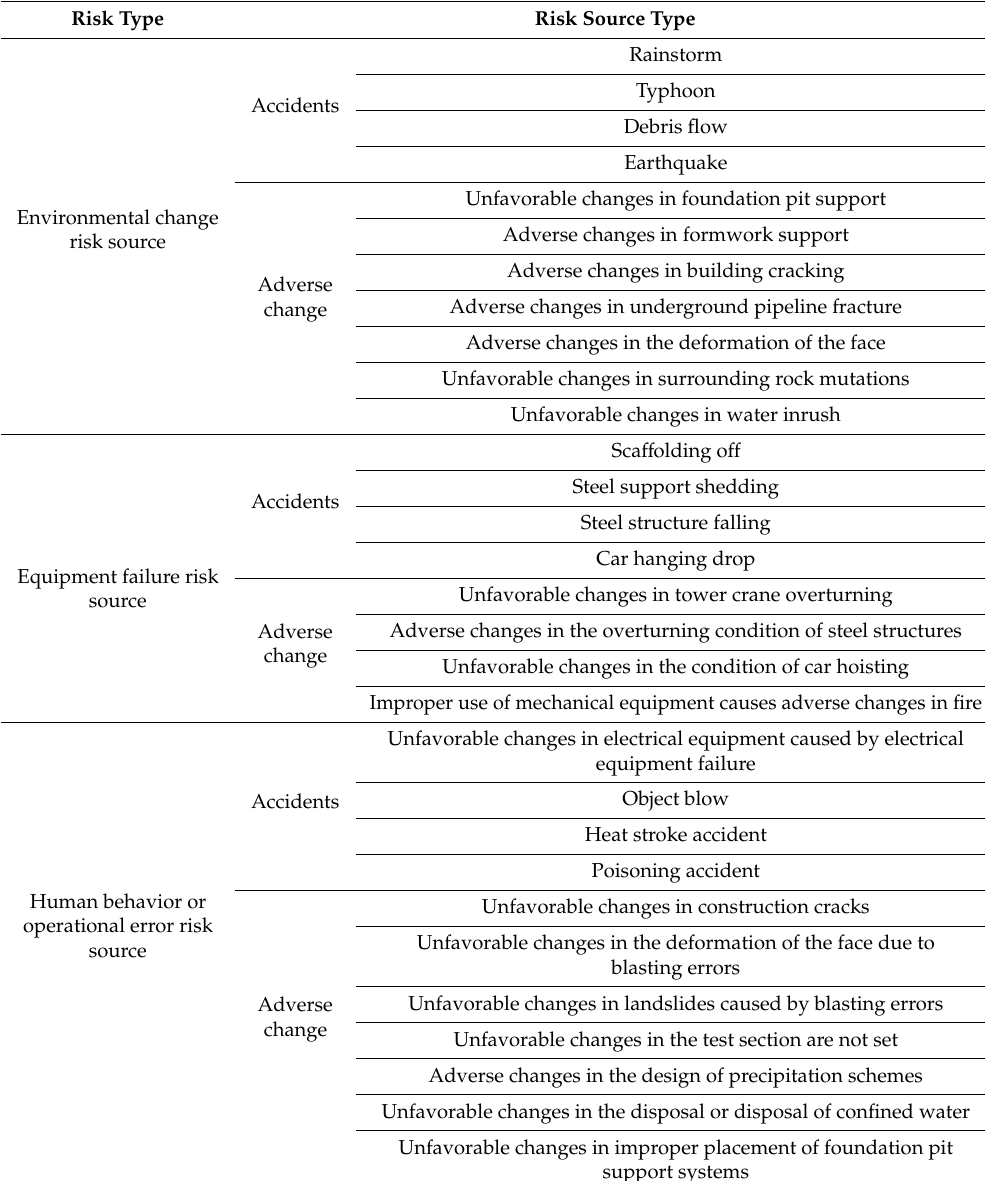
Table 3. Subway construction safety risk